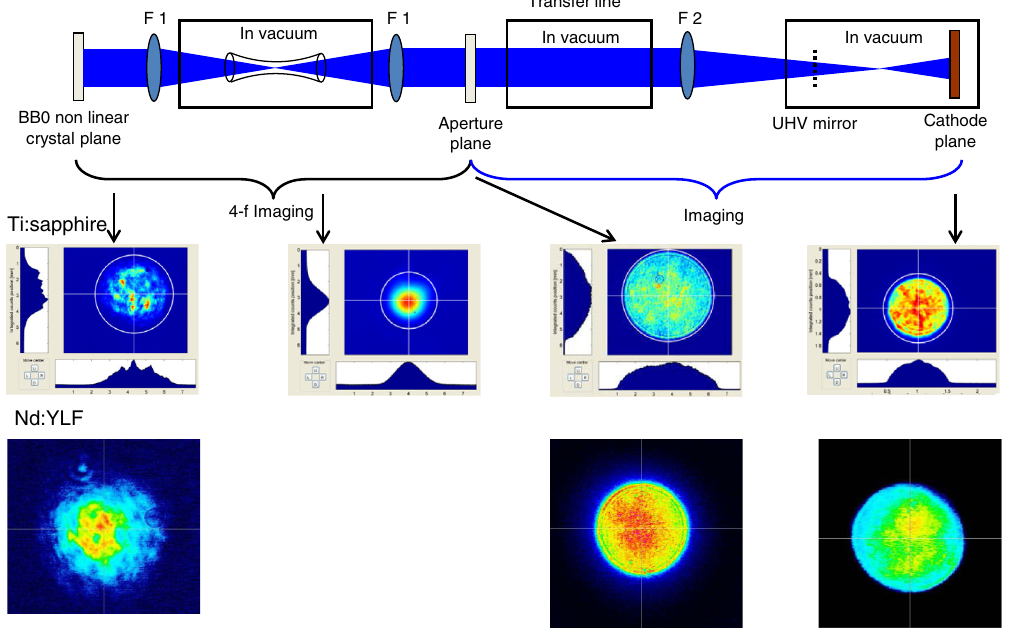
FIG. 5. Beam transport and transverse beam profiles along the beam line for the Ti ∶ sapphire and Nd ∶ YLF gun laser